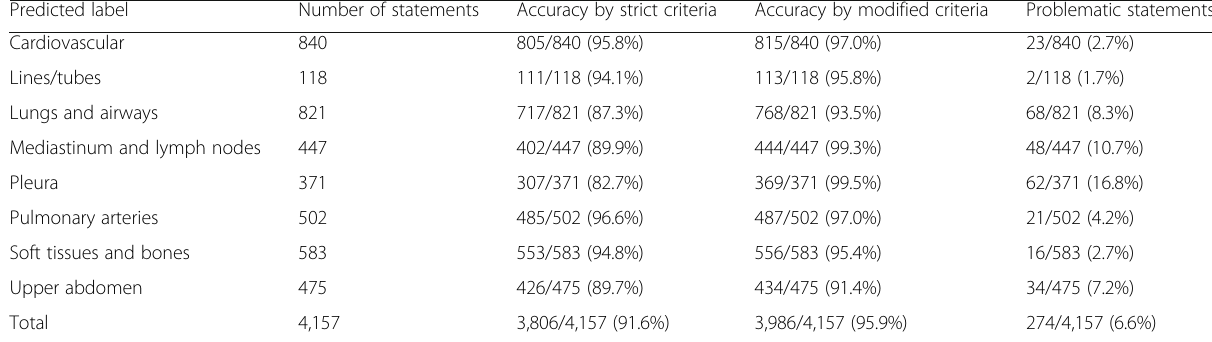
Table 1 Accuracy of individual predicted labels Predicted label